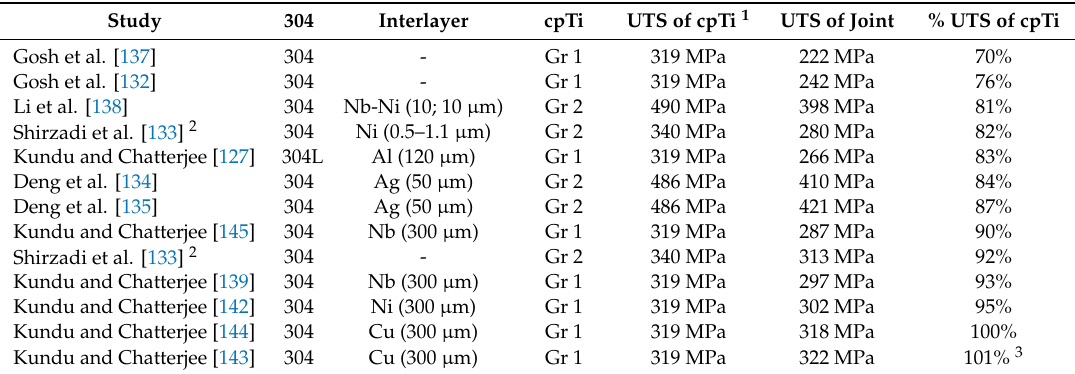
Table 5. Comparison of the ultimate tensile strength (UTS) of di ff usion bonded and TLP bonded 304 with commercially pure titanium (cpTi)